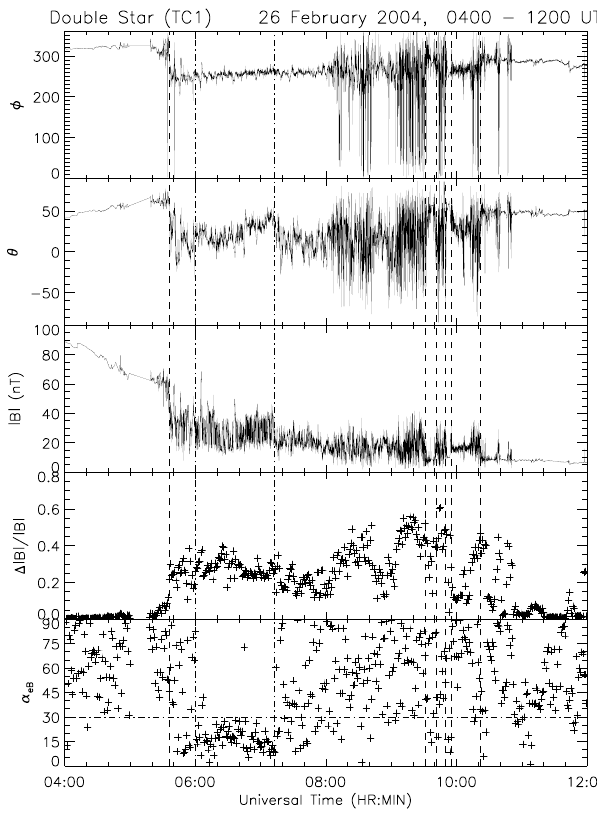
Fig. 2. Magnetic field data for the crossing of the magnetopause (first vertical dashed line at ∼ 05:38UT), magnetosheath and bow shock (last 5 vertical dashed lines after 09:20UT) observed by TC- 1 on 26 February 2004. From the top to bottom panels, shown are the azimuth ( φ ) and elevation ( θ ) angles of the magnetic field in GSE coordinates, magnetic field magnitude | B | , the fluctuation of the field 1 | B | / | B | and the angle between the maximum variance di- rection and average magnetic field α eB , respectively. The two ver- tical dash-dotted lines show the interval during which mirror mode waves are observed.